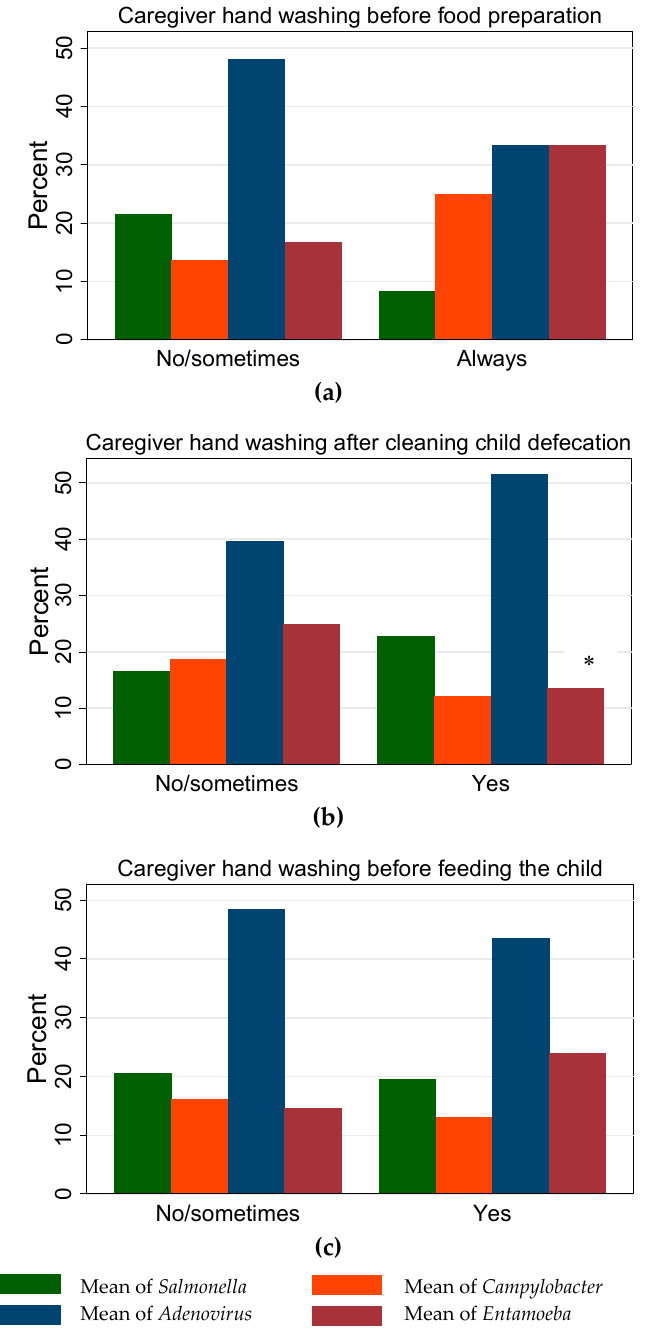
Figure 2. Caregivers’ hygienic practices; ( a ) hand washing before food preparation; ( b ) hand washing after cleaning child defecation; ( c ) hand washing before feeding the child, in relation to percentage of enteropathogens cases (Figure 1) detected in diarrheal children ( n = 155) < 5 years old in Thi-Qar Governorate, Iraq. The symbol (*) denote bars of categories with statistical differences.